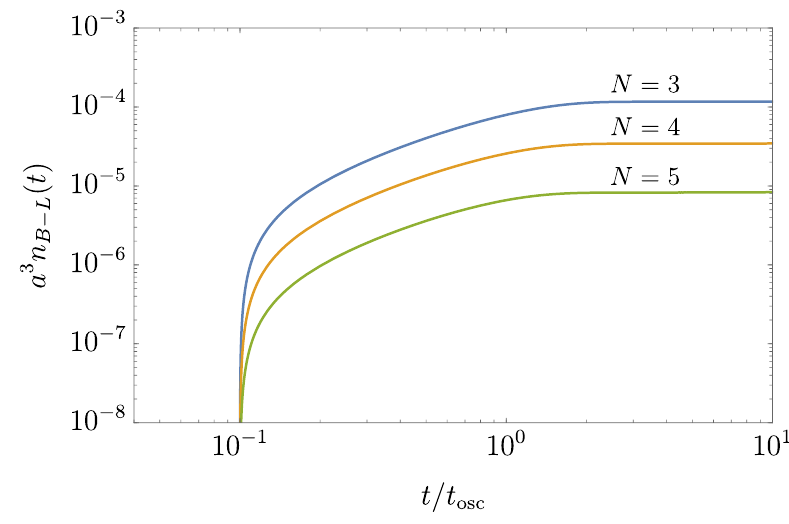
Figure 3 . Time evolution of B − L charge density of the AD field in a comoving volume. We choose N = 3 with c K = 5 (blue curve), N = 4 with c K = 1 (yellow curve), and N = 5 with c K = 1 / 3 (green curve). We take 3 Nθ ini = c A = c H = − q B − L = 1 for each